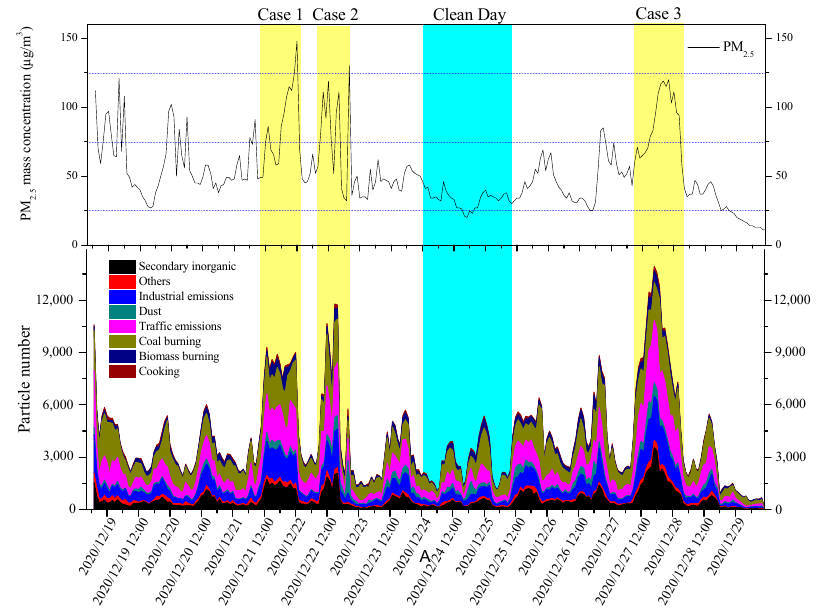
Figure 6. Temporal variation in the PM 2.5 mass concentration and eight types of number concen- tration.